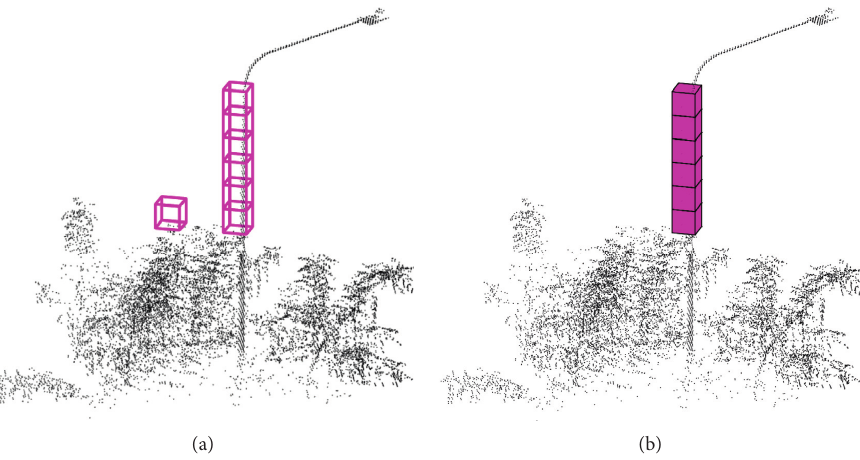
Figure 7: Selecting voxels based on vertical height. (a) A set of voxels satisfying horizontal cross section analysis; (b) voxel cluster containing a pole trunk, using the vertical height constraint.